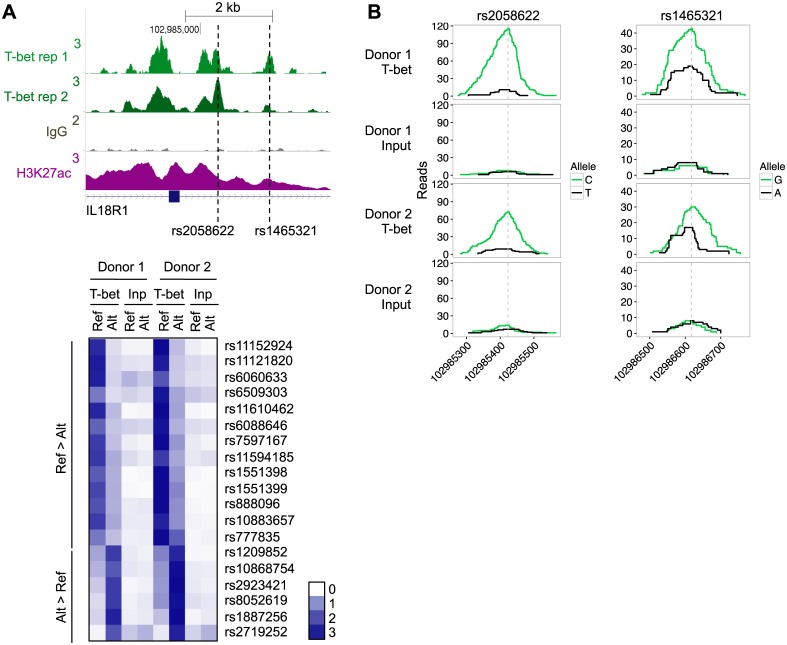
Genetic variants alter T-bet binding in vivo.A. Genomic context of rs1465321 and rs2058622, which is in high LD (r2 = 1.0) with rs1465321. B. T-bet ChIP and input sequencing reads that cross rs2058622 (chr2: 102985274–102985565; left) or rs1465321 (chr2: 102986477–102986768; right) in two donors heterozygous for rs1465321. In each case, the number of reads that match the reference allele are shown in black and the alternative allele in green. C. T-bet ChIP and input (Inp) sequencing reads at the set of 19 additional heterozygous SNPs that exhibited allelic imbalanced T-bet binding. For each SNP, the color shows fold-enrichment in the number of sequencing reads matching the Ref or Alt allele, relative to the average number of reads across all samples, as indicated by the scale on the right hand side. SNPs are divided into those exhibiting greater T-bet binding to the reference (Ref) allele (Ref > Alt, top) or the alternative (Alt) allele (Alt > Ref, bottom).